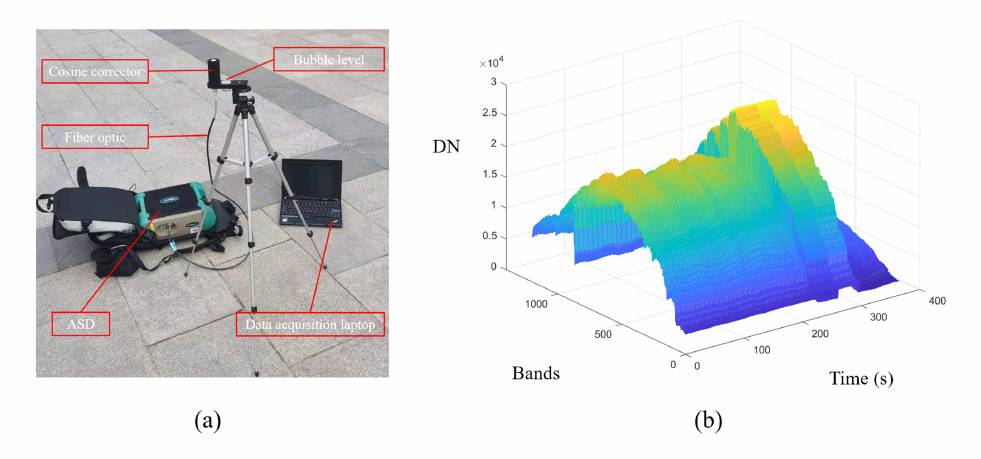
Figure 2. ( a ) The atmospheric Downwelling Irradiance Measuring Device (DIMD) and ( b ) the variation of outdoor downwelling irradiance over